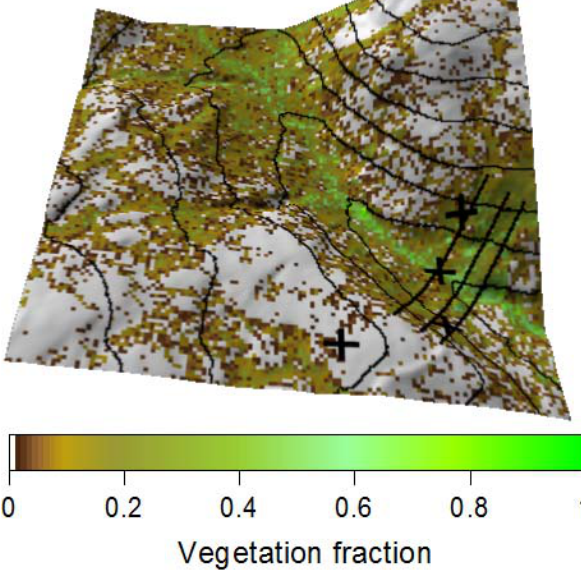
Figure 1. 8m resolution lidar-based digital elevation map of the 1km × 1km area around the valley in the Granger basin, overlaid by a vegetation fraction map and a contour map (1360 to 1480m at 20m interval). Four meteorological stations (from north to south: south-facing, tall shrubs, north-facing and short shrub stations) and the three snow depth transects are shown in